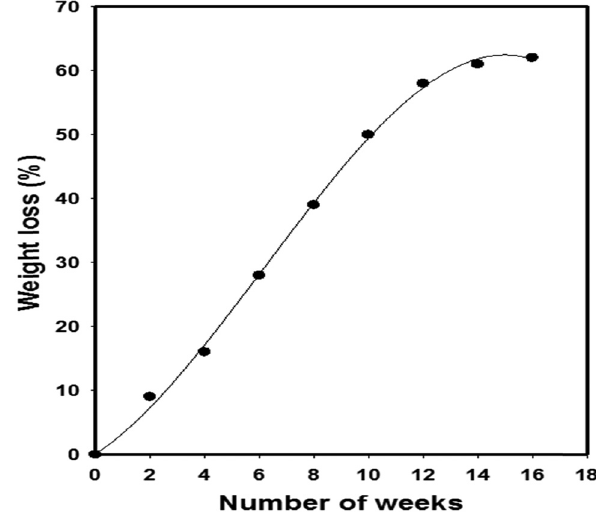
Figure 10: Biodegradability of ( PVP:CMC ) /CA/G/ZnO nano fi lm over 16